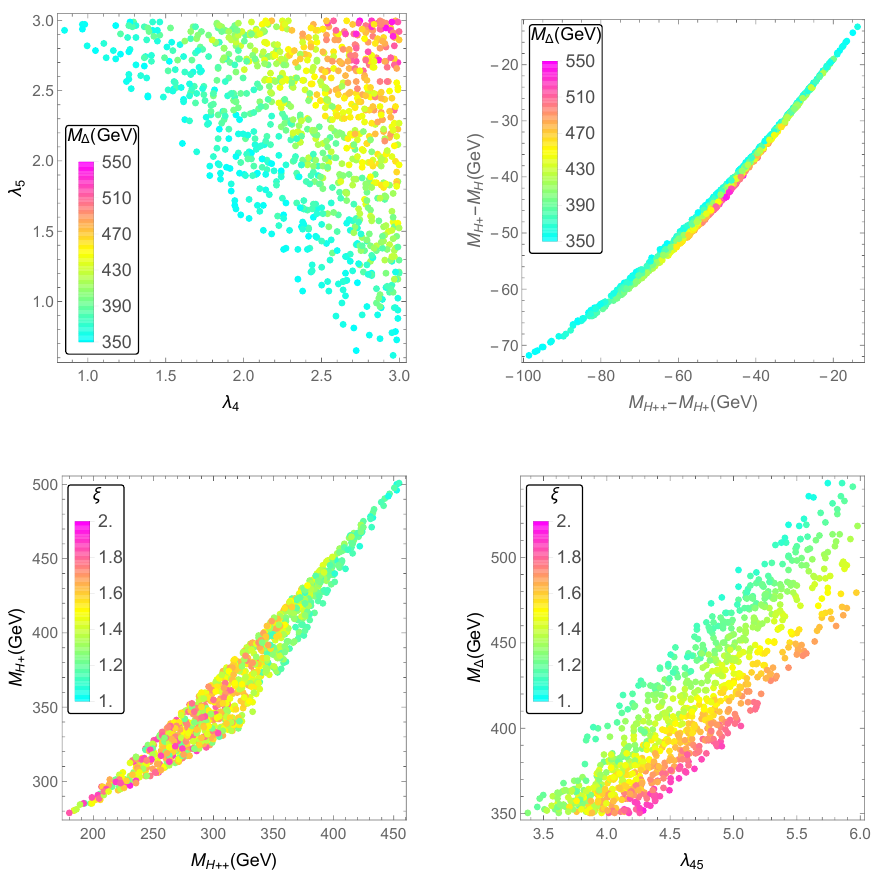
Figure 4 . Same as figure 3 but for our setup